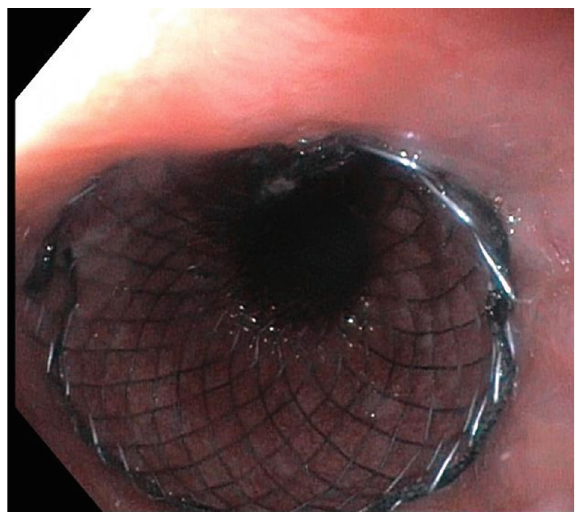
Figure 1: Stent placed in the